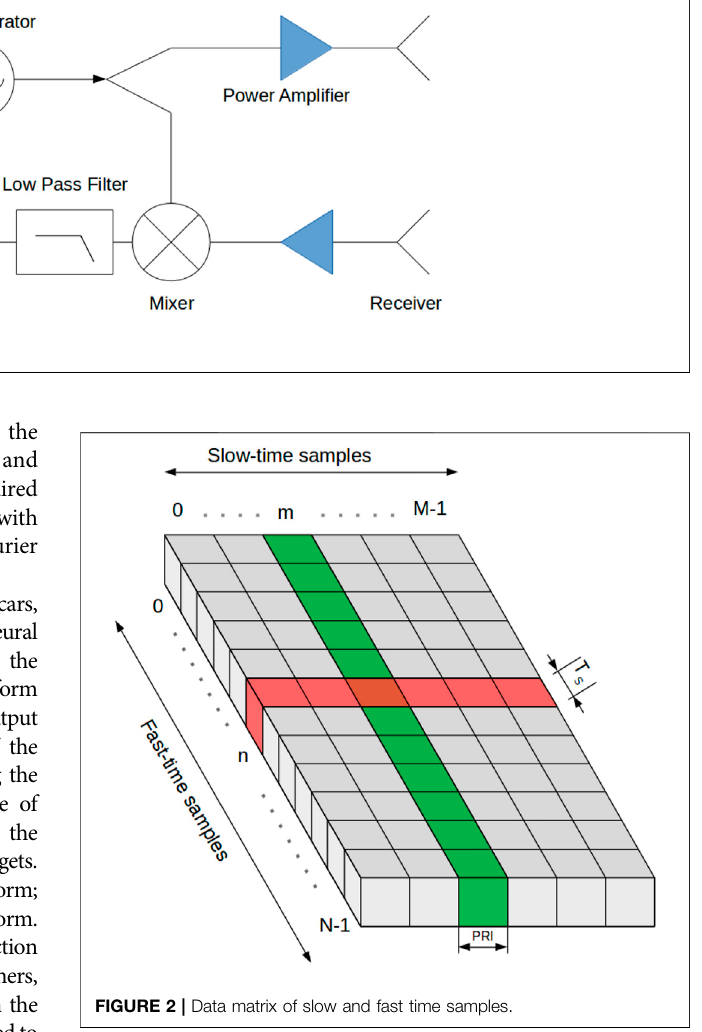
FIGURE 2 | Data matrix of slow and fast time